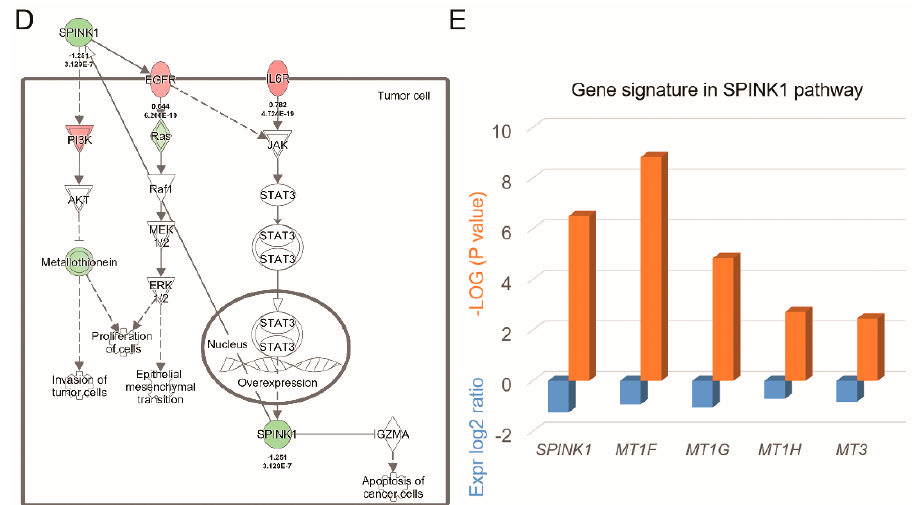
Figure 2. Knowledge-based transcriptomic analysis reveals that the SPINK1 pathway is the top 1-altered canonical signaling pathway by DDX3X . ( A ) A total of 525 cases were divided into 200 cases in the high DDX3X group and 325 cases in the low DDX3X group based on the expression level of DDX3X and association with clinical outcome. ( B ) The hierarchical clustering of gene signatures in the DDX3X high and low groups. ( C ) The differentially expressed gene signatures among the high versus low DDX3X group were analyzed by Ingenuity Pathway Analysis (IPA). Significant canonical pathways determined by the level of gene up- and downregulation and the amount of target overlaps in the database are listed. ( D ) The SPINK1 signaling axis is shown along with the expression ratio and statistical p value. The expression level was log2-transformed. Up- and downregulation are presented in red and green, respectively. ( E ) The gene targets with significant expression alterations in the SPINK1 signaling pathway are listed.